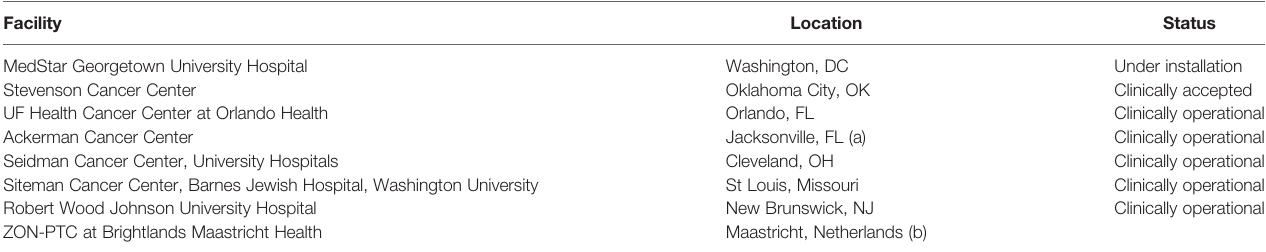
TABLE 8 | MEVION S250 compact proton therapy systems.